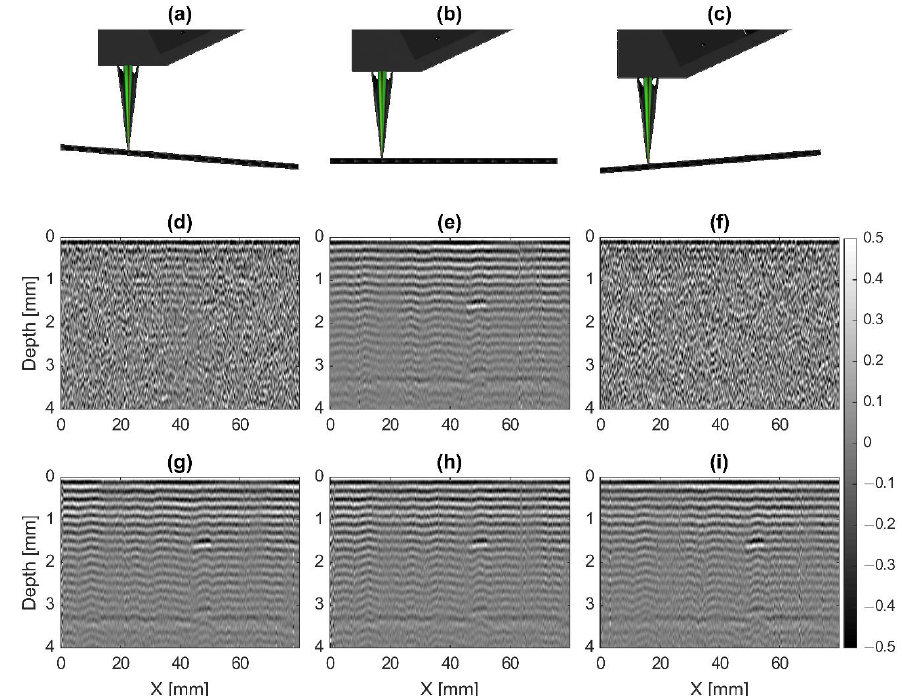
Figure 5. B-scan diagrams and results when the sample is rotated around the Y -axis with DACS regulation ON and OFF. Diagrams showing the sample rotated −2° ( a ), 0° ( b ) and +2° ( c ). ( d – f ) Results obtained with regulation OFF for sample positions ( a – c ), respectively. ( g – i ) Results obtained with regulation ON for sample positions ( a – c ), respectively.